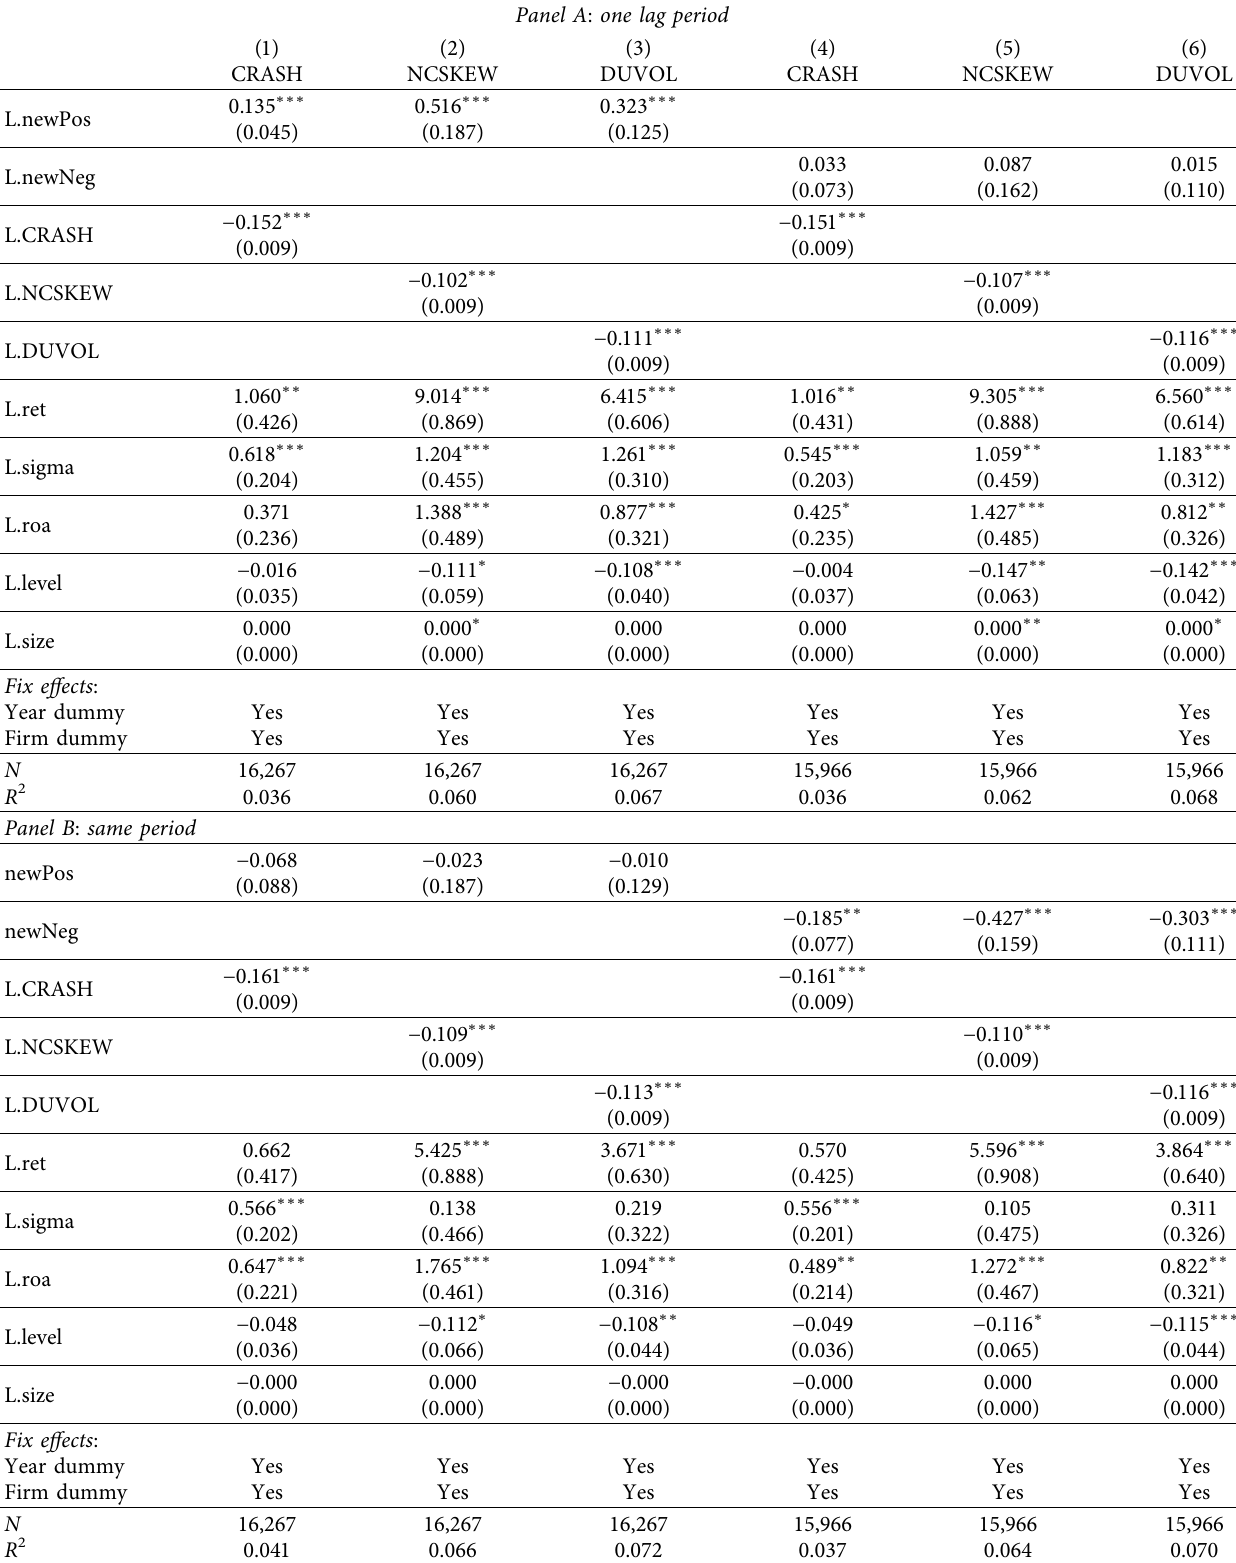
Table 5: Positive sentiment and negative sentiments of news